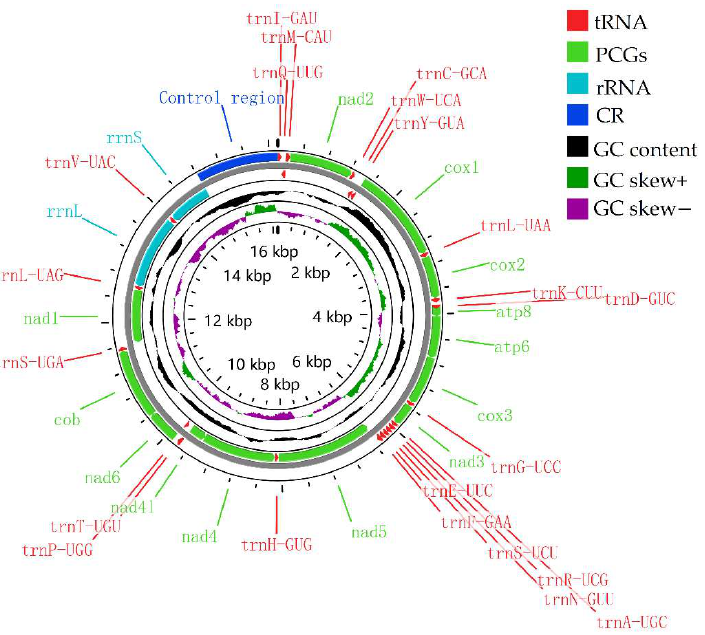
Figure 2. Mitogenome-pattern map of G. orientalis . The first circle shows the gene map (PCGs, rRNAs, tRNAs, and control region). Arrows in the second and third circles indicate the direction of gene transcription. The fourth circle shows the GC content and the fifth shows the GC-skew values. GC content and GC skew are plotted as the deviation from the average value of the entire sequence.